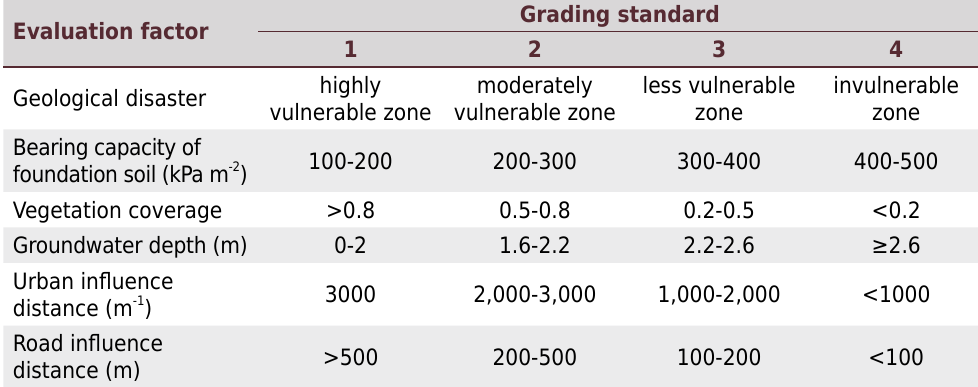
Table 3. Evaluation index values for construction suitability of unutilized land